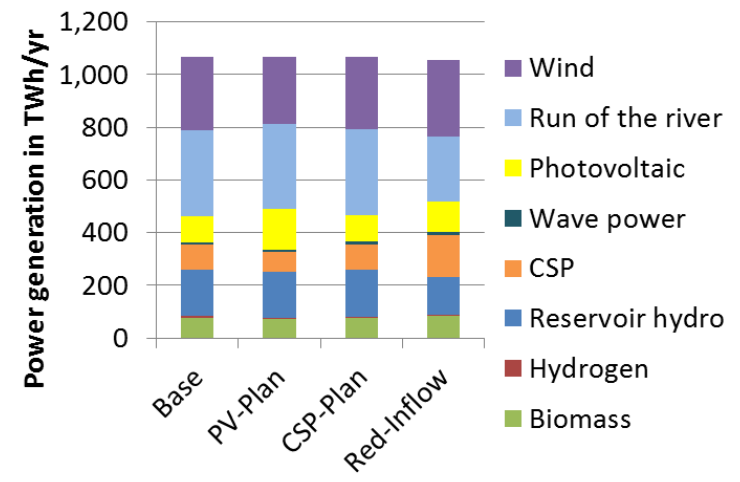
Figure 6. Scenario comparison of the resulting power generation structure in 2050.